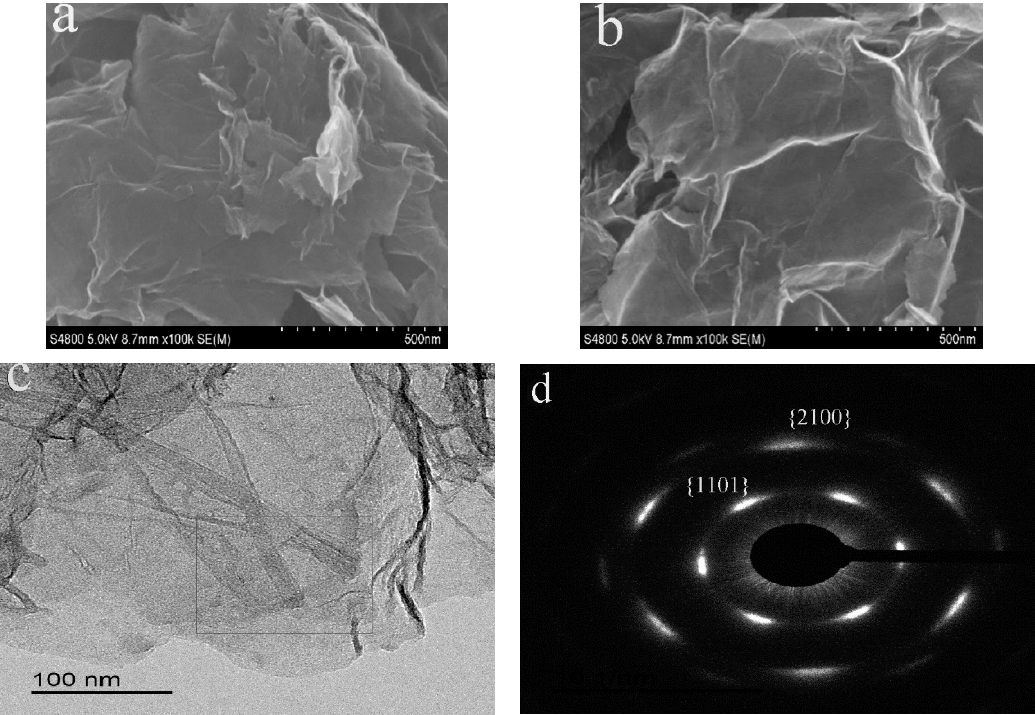
Figure 4. ( a , b ) Scanning electron microscopy (SEM) image of TPG. ( c ) Transmission electron microscopy (TEM) image of TPG. ( d ) Corresponding selected-area electron diffraction (SAED) of TPG nanosheet area outlined with a black rectangle in Figure 4c.